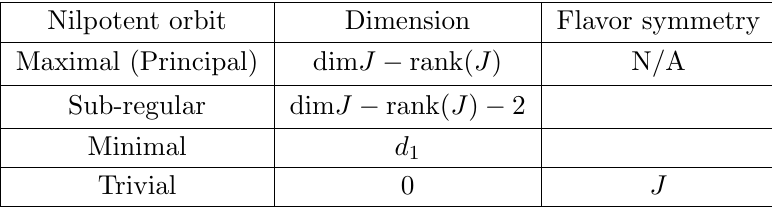
Table 4 . Some special regular singularities. Here d 1 is equal to one plus the number of positive roots not orthogonal to the highest root.